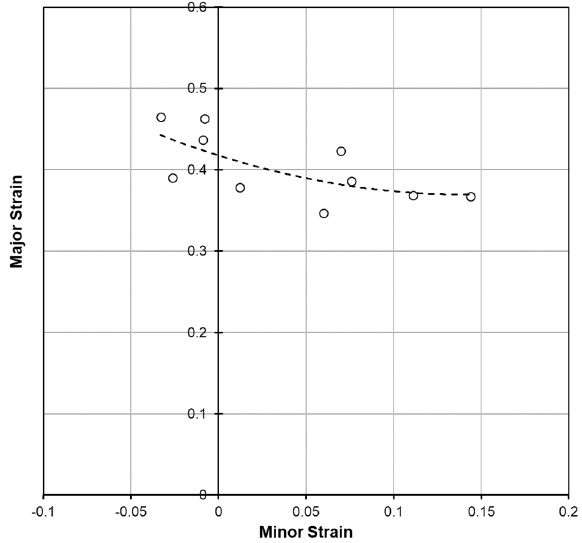
Figure 2. Computed forming limit curve for 1.4404 with a thickness of 0.05 mm [Vitesco Technologies Group AG].